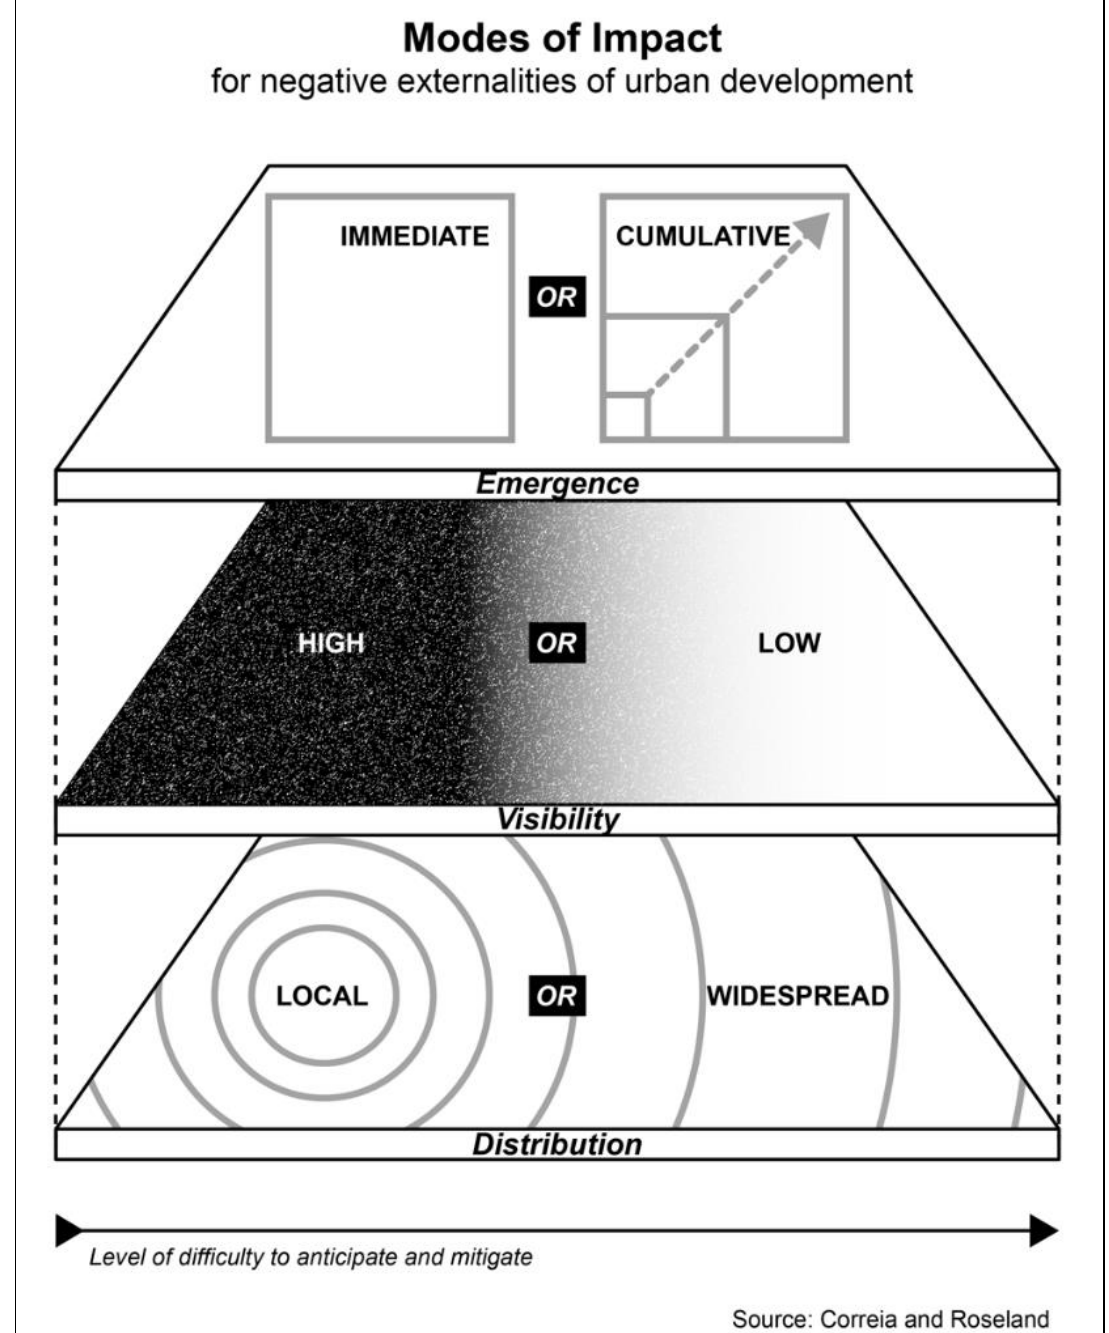
Figure 5. Modes of Impact. Negative externalities can be visualized by modes of impact. While the three different modes exist independently, they occur concurrently in a layered hierarchy. The first mode, distribution, explores whether an impact is local or widespread; the second mode, visibility, determines whether an impact is readily observable and measurable; the third mode, emergence, describes whether an impact is felt immediately or incrementally. For example, increased greenhouse gas emissions would have widespread distribution, low visibility, and cumulative emergence. Judging from discussion of negative externalities in the literature, those with widespread distribution, low visibility, and cumulative emergence (with placement at the far right side of this graphic) are most difficult to anticipate and